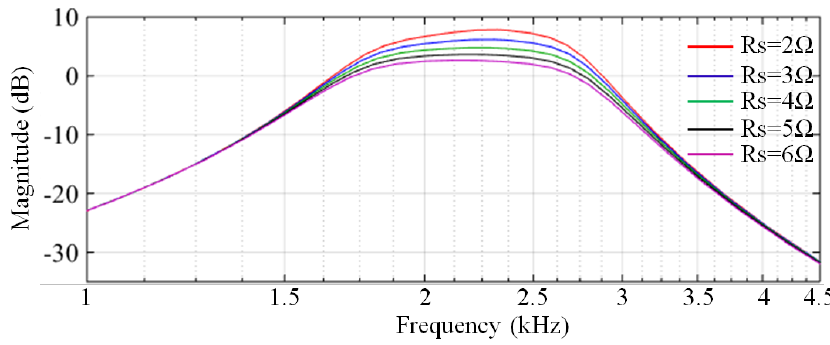
Figure 9. Monte Carlo analysis of the equivalent resistance of the pickup coil.